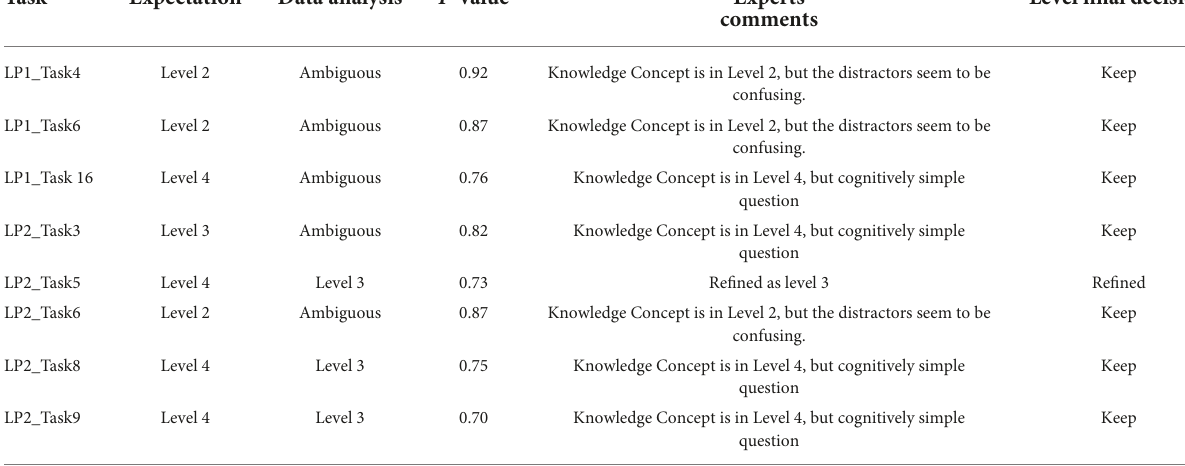
TABLE 6 Communicating with content